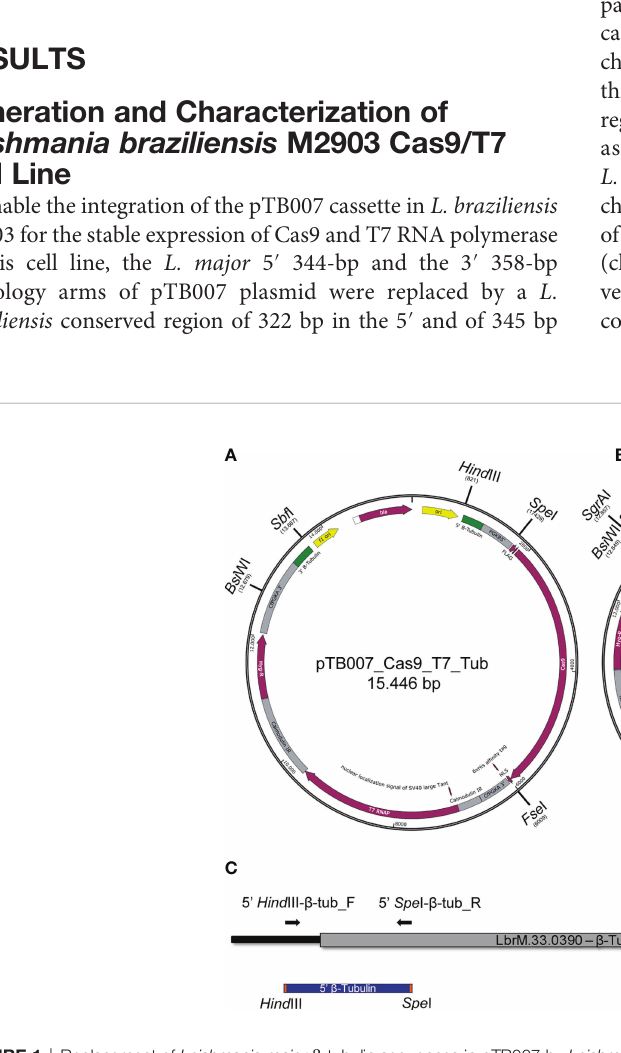
FIGURE 1 | Replacement of Leishmania major b -tubulin sequences in pTB007 by Leishmania braziliensis b -tubulin conserved sequences. (A) Original plasmid for episomal expression of Cas9 and T7 RNA polymerase in Leishmania spp. and for the integration and stable expression of these proteins in L. major and Leishmania mexicana (12). The restriction enzymes used for directional cloning were Bsi WI and Sbf I for replacement of 3 ′ end (green) and Hin dIII plus Spe I for replacement of 5 ′ end (green). (B) Leishmania major sequences [represented in green in (A) ] were replaced by L. braziliensis sequences [represented in blue in (B) ] allowing the integration of this cassette in this species for the stable expression of Cas9 and T7 RNA polymerase. PGKB5 ′ that was removed in the fi rst cloning step was returned to the plasmid by directional cloning using the enzyme Spe I. (C) Schematic representation of the L. braziliensis b -tubulin sequences chosen for replacement in pTB007 (blue). Primers used to amplify the target region are represented as black